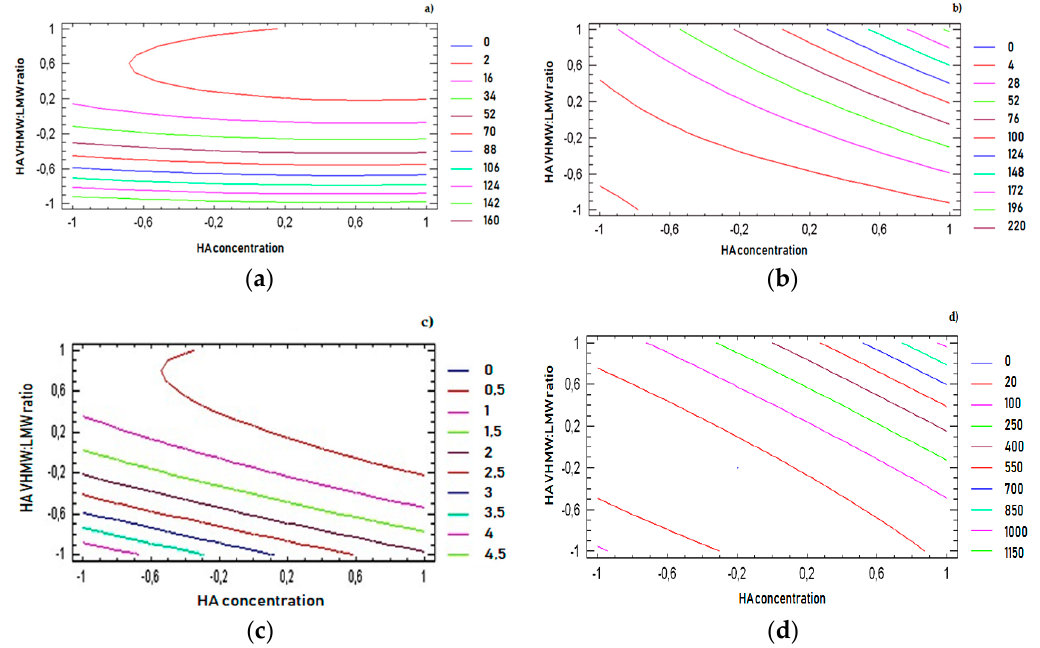
Figure 4. Two-dimensional (2D) contour plots drawn according to the best-fit model for each response variable: ( a ) frequency at cross over, ( b ) viscosity at cross over, ( c ) tan δ at 2.5 Hz, ( d ) dynamic viscosity in rest condition (0.01 s − 1 shear rate).